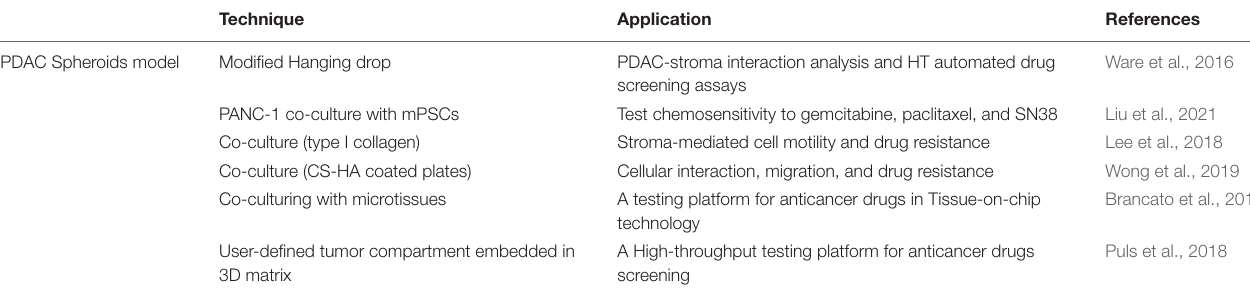
TABLE 3 | Three-dimensional spheroid models for PDAC research and their applications in